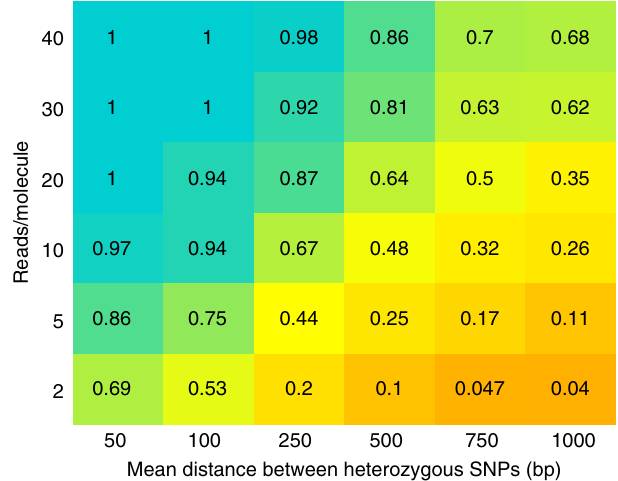
Fig. 6 ReMIX detects recombinant molecules with high sensitivity. In simulated data, the sensitivity of ReMIX to detect recombinant molecules (low = orange; high = blue; and numbers within boxes) is high at moderate to high heterozygosity levels ( x -axis) and moderate to high sequencing depth ( y -axis)